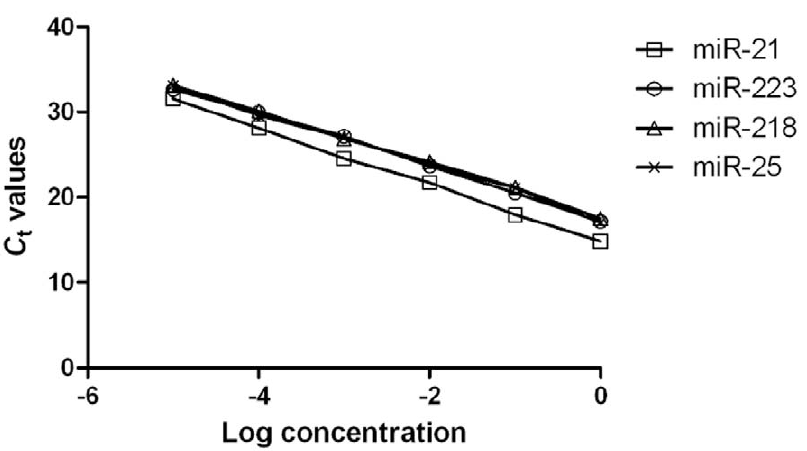
Figure 1. Standard curve of miR-21, miR-223, miR-218 and miR-25 using synthetic miRNAs. Ten-fold serial dilution of synthetic miRNA was used to generate the standard curves. Linearity was confirmed within these concentrations for miR-21, miR-223, miR-218 and miR-25 ranging from 0.1 to 0.000001 fmol. ( miR-21 : y= 2 3.337x + 14.77 (R 2 =0.999); miR-223 : y= 2 3.121x + 17.37 (R 2 =0.997); miR-218 : y= 2 3.071x + 17.79 (R 2 =0.998); miR-25 :y= 2 3.114x + 17.47 (R 2 =0.993)).